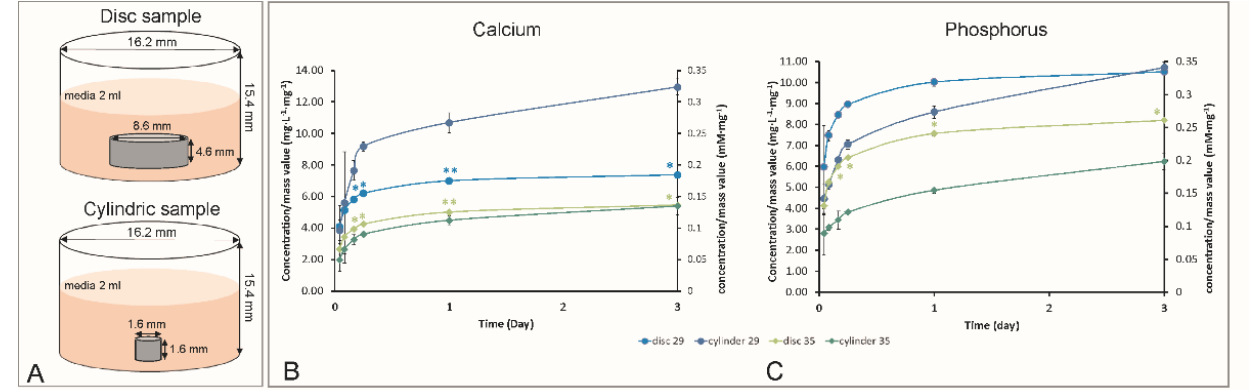
Figure 6. Effect of sample dimensions on ion release. ( A ) Graphical overview of sample dimensions and experimental comparisons. Comparison of ion release rates for ( B ) calcium or ( C ) phosphorus, between two PMCs formulations that previously showed significant differences in Figure 3 (#29 and #35), and between different sample dimensions (disc vs. cylinder) and surface area to volume ratios. Sample dimensions were 8.9 mm × 4.5 mm (disc) and 1.6 mm × 1.6 mm (cylinder), all cured to an initial setting time. The ion concentrations (Y axis) are normalized to sample mass (per milligram), as the final material densities differed between different formulations. ** and * indicate p < 0.01, and 0.05, respectively, for comparisons made between sample dimensions, at each time point (Games − Howell) .